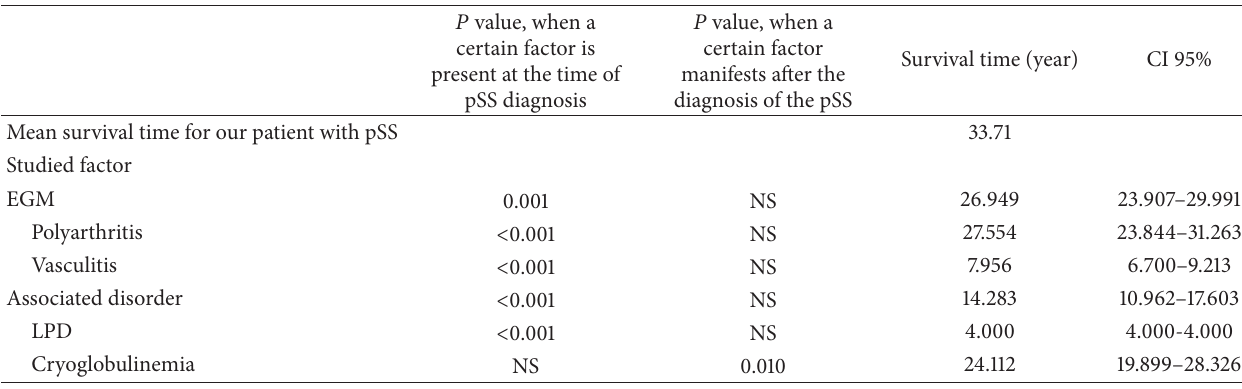
𝑃 value, when a 𝑃 value, when a certain factor is certain factor Survival time (year) CI 95% present at the time of manifests after the pSS diagnosis diagnosis of the pSS